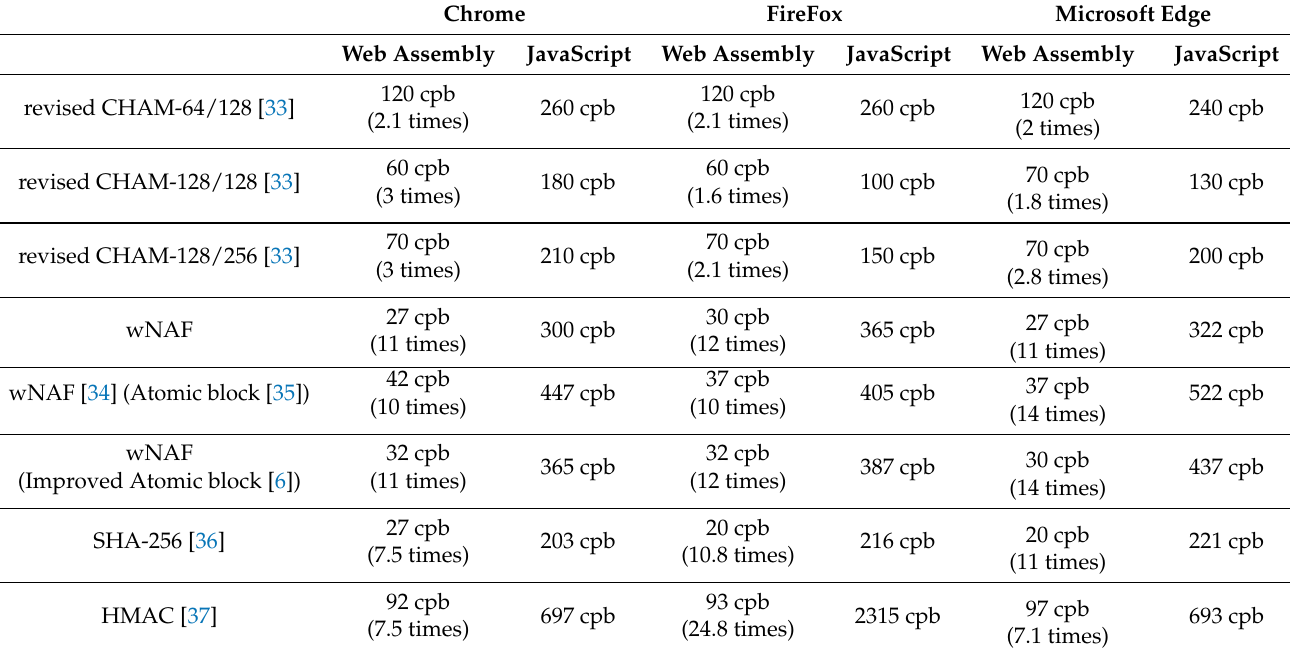
Table 6. Web Assembly and JavaScript performance measurement and comparison through cryptographic algorithm implementation (cpb: Cycle Per Byte) [6]. Chrome FireFox Microsoft Edge Web Assembly JavaScript Web Assembly JavaScript Web Assembly